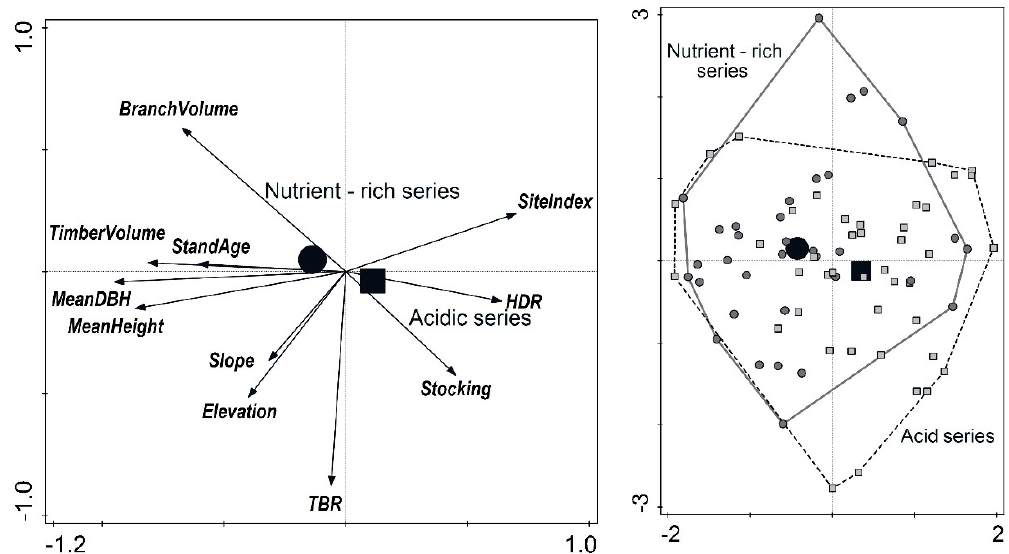
Figure 10. Ordination diagram showing the relationships of the PCA among dendromass characteristics (timber volume, branch volume, and timber-to-branch volume ratio-TBR), stand characteristics (mean height, mean diameter at breast height-DBH, stand age, height-to-breast height diameter ratio-HDR, and stocking), and sample plot characteristics (elevation, slope, and site quality class) on the left side and the classified diagram was di ff erentiated according to edaphic factors ( (cid:8) nutrient–rich series, (cid:4) acid series) on the right side; small dots and squares indicating 76 sample